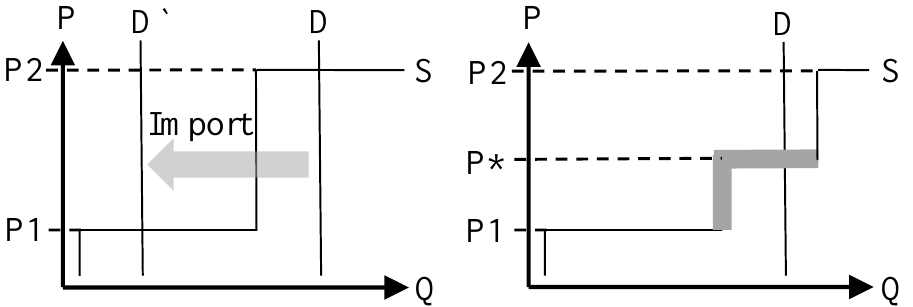
Figure 3. Comparison of price determination for exogenous and endogenous exchange flows